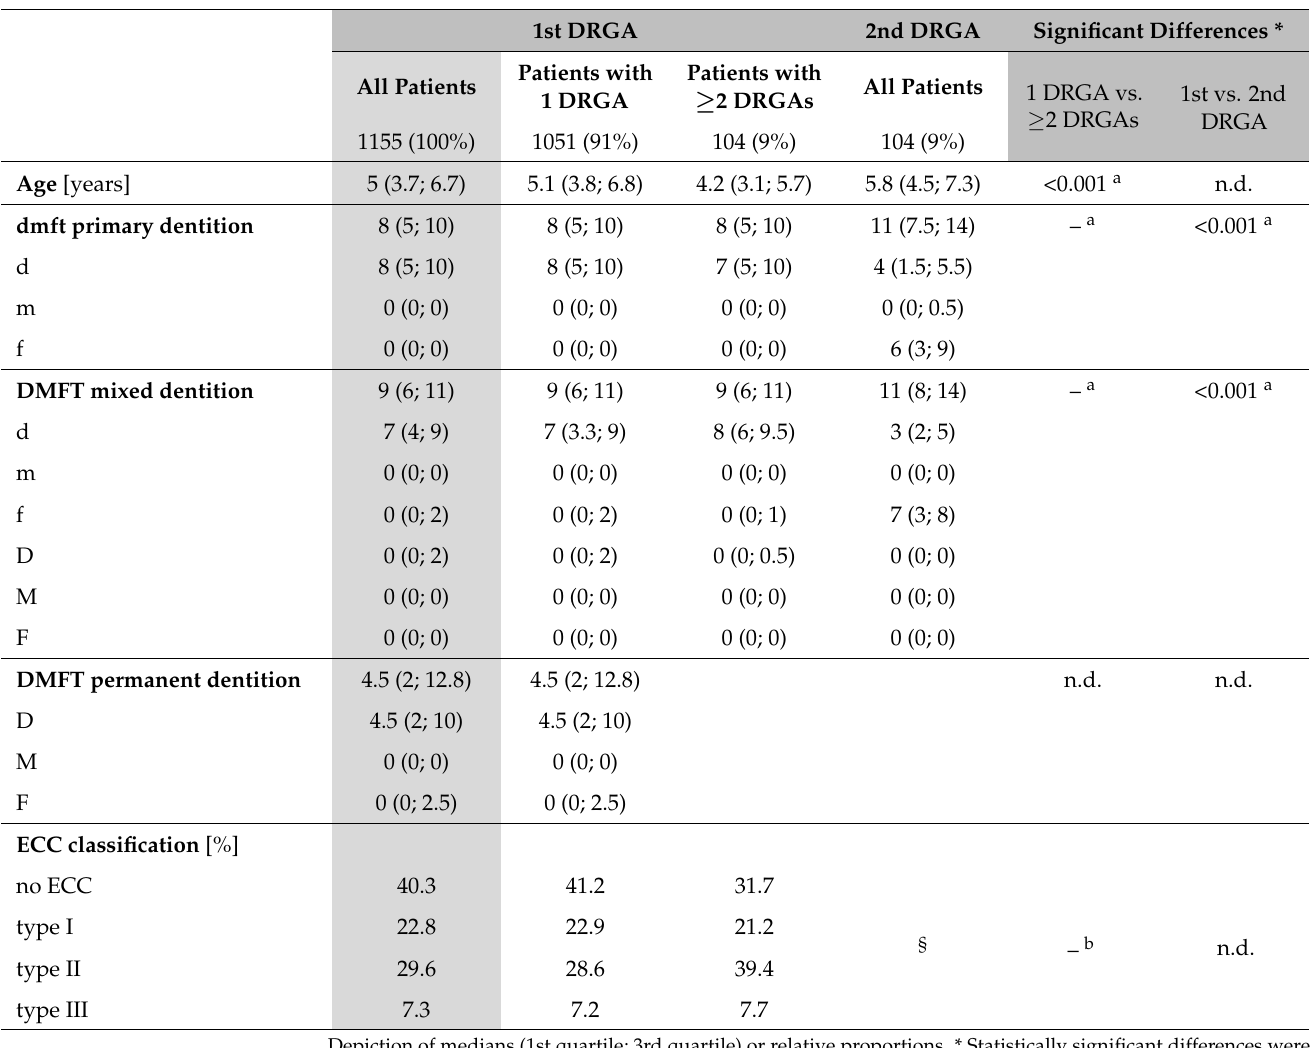
Table 2. Dental status of all included patients at their respective